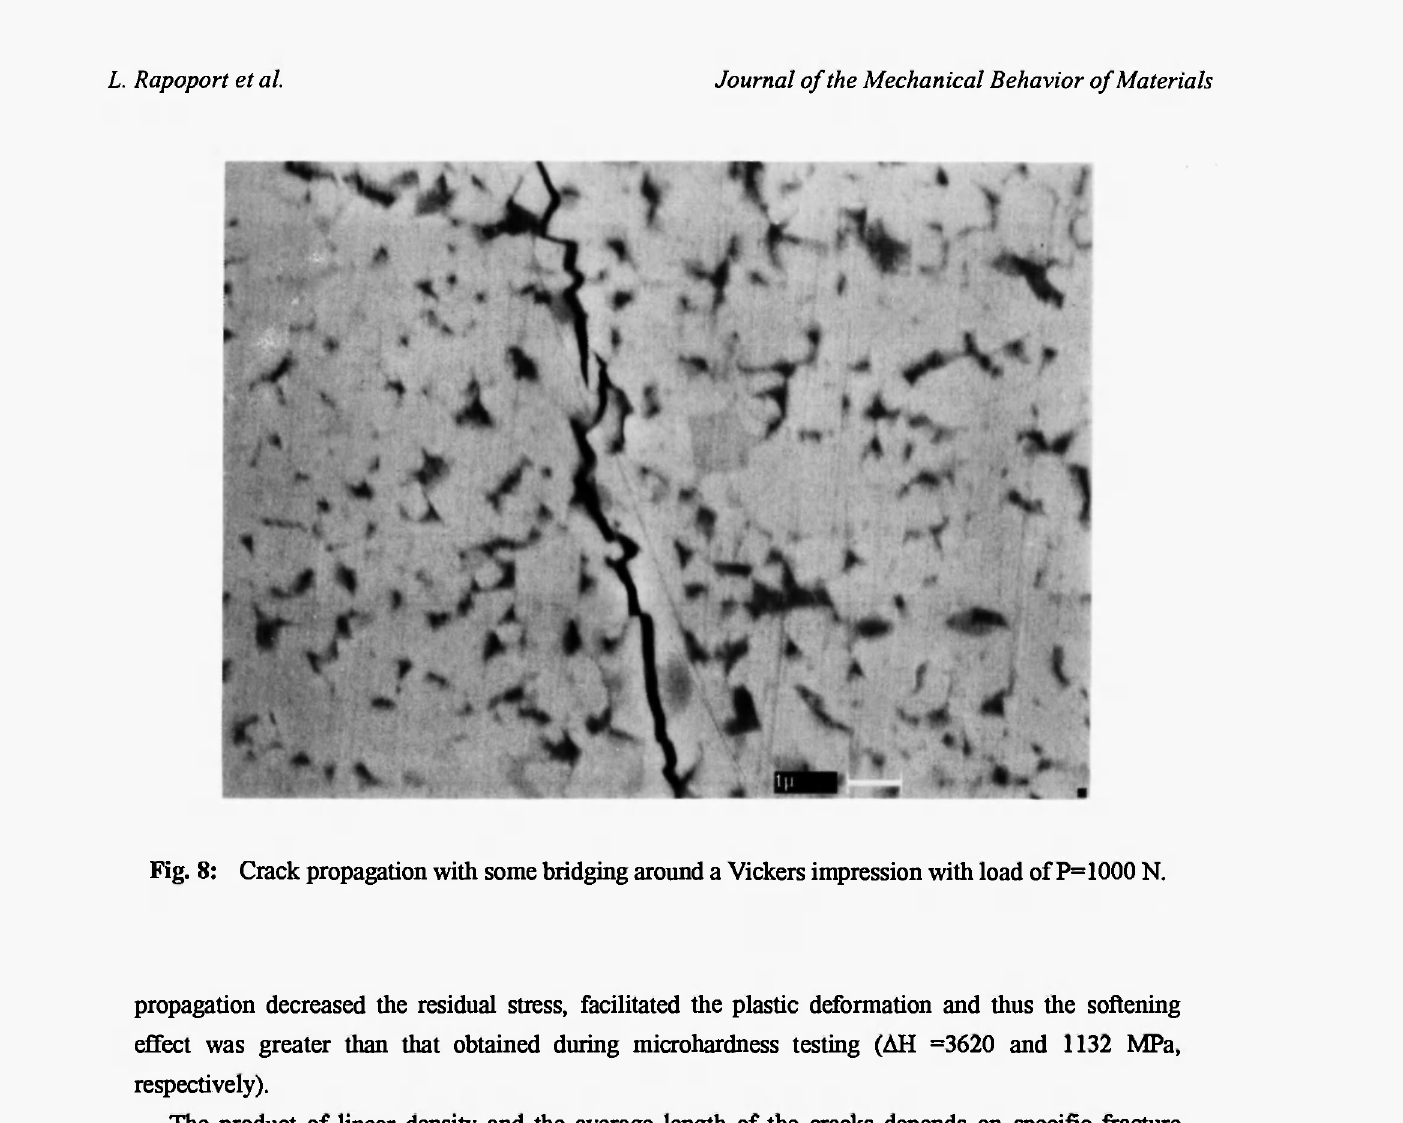
Fig. 8: Crack propagation with some bridging around a Vickers impression with load of P= 1000